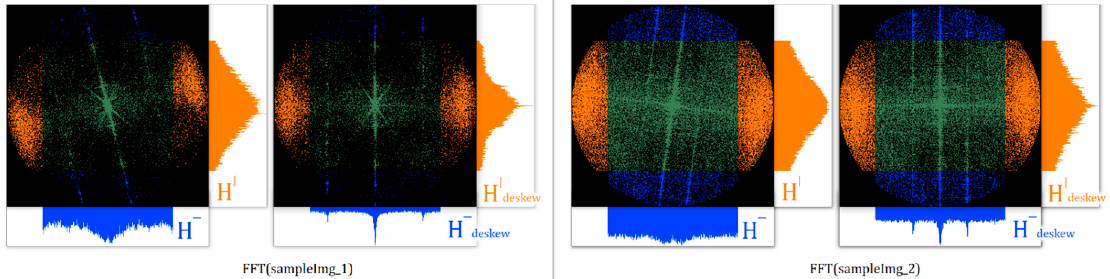
Figure 3. Two examples of frequency domain projection profiling, deskewing by variance maximization for each axis, i.e., finding the angle Θ deskew = argmax Θ ( σ 2 (H | ( Θ )) + σ 2 (H ─ ( Θ )).